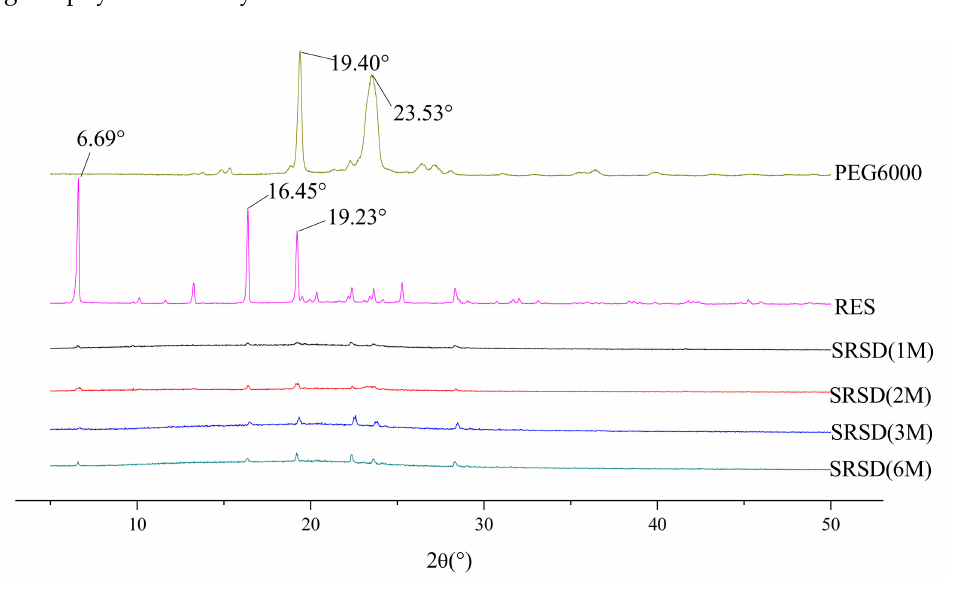
Figure 14. XRD diagram of RES/RS/PEG6000-SRSD at different